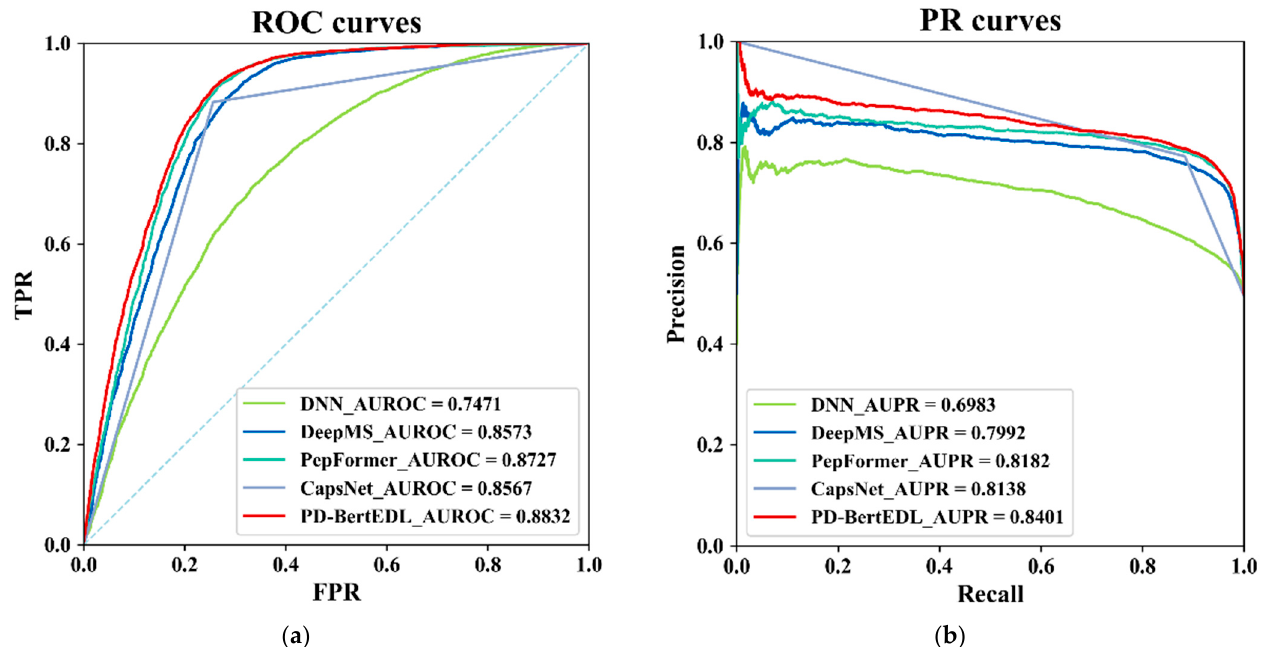
Figure 2. The results of PD-BertEDL and other predictors: ( a ) AUROC values; ( b ) AUPR values. The AUC and AUPR of PD-BertEDL are 88.32% and 84.01%. Compared with DNN, CapsNet, DeepMS, and PepFormer, the AUC (AUPR) value of the PD-BertEDL method increased by 13.61% (14.18%), 2.65% (2.63%), 2.59% (4.09%), and 1.05% (2.19%), respectively.